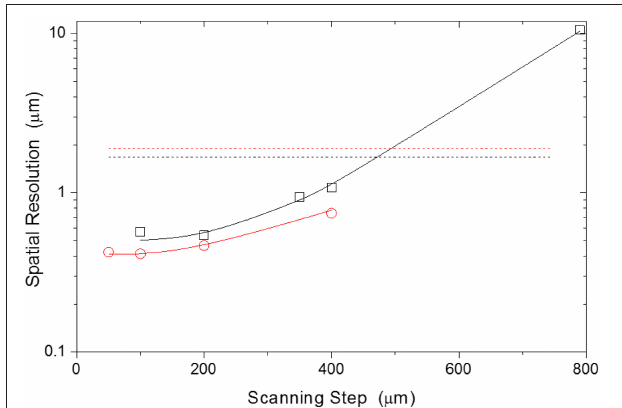
FIGURE 6 | Spatial resolution of the UET–1.3 thermometers for different scanning steps. The red circles and black squares correspond to the mappings using the 200 and 450 μ m diameter fiber, respectively. The solid lines are guides for the eyes. The interrupted red and black lines correspond to the Rayleigh spatial resolution limit of the 200 and 450 μ m diameter fibers, respectively.